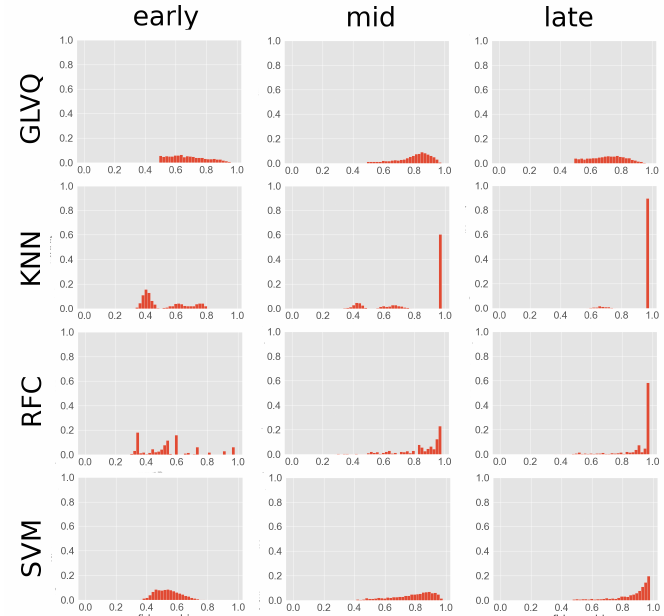
Figure A1. Configrams of evaluated classifiers extracted at the beginning, middle and end of training. The different kinds of confidence estimations are visible in the configrams,